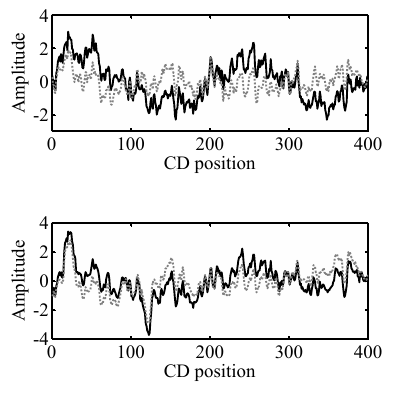
Figure 6: The effect of dynamical disturbances to pro- file information for Property 1 (solid line on top) and Property 2 (solid line on bot- tom). The dotted lines are the corresponding steady-state disturbance profiles plotted also in Figure 5.